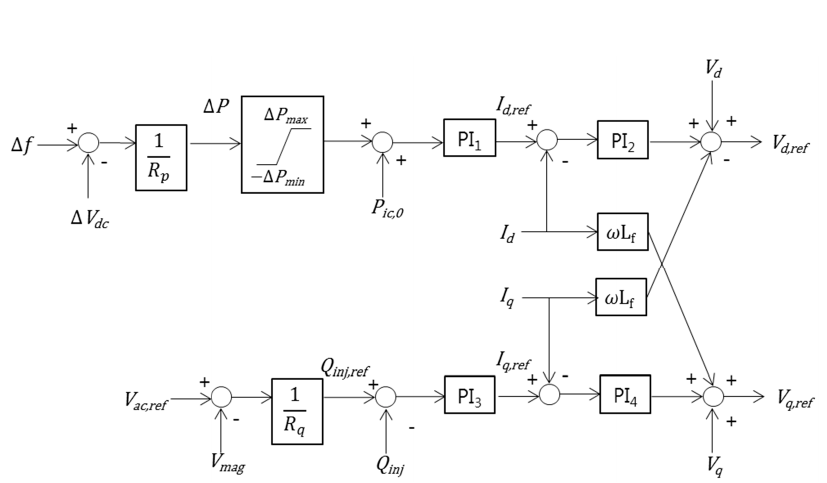
Figure 9. Proposed droop control scheme for the hybrid AC/DC microgrid.